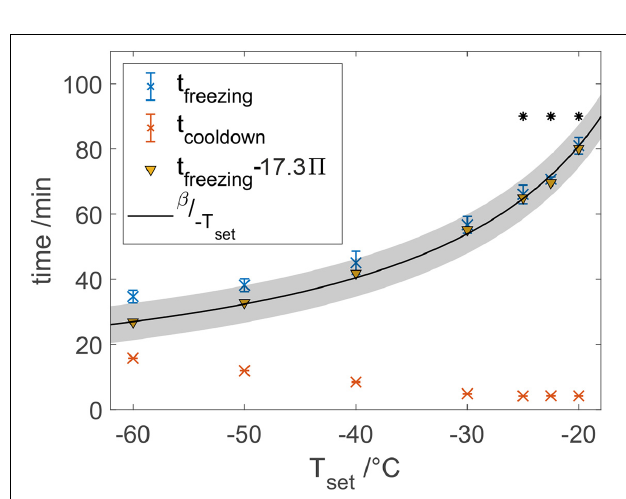
FIGURE 4 | Freezing and cooldown times at different set temperatures. Data marked points with a star were used to calibrate a model after Eq. 2 with β = 1619, where the gray area shows the 95% confidence